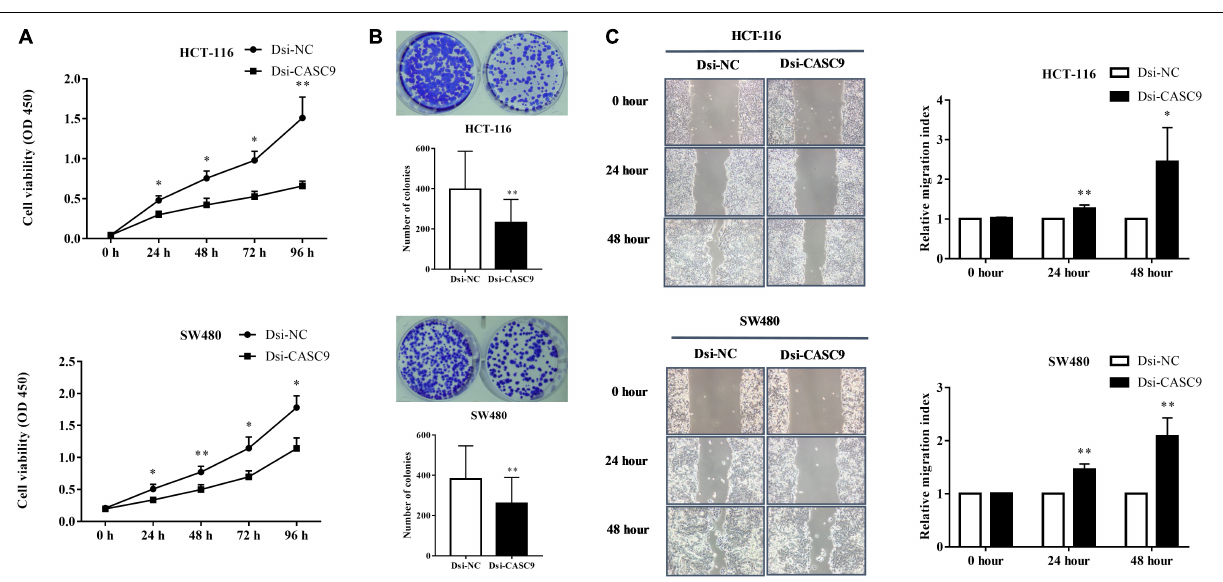
FIGURE 3 | Silencing of CASC9 reduced cell viability and colony formation and increased migration index of CRC cells. (A) The silencing of CASC9 led to significant decrease in HCT-116 and SW480 cell proliferation ( n = 4). (B) As determined by colony formation assay, the numbers of colonies in HCT-116 and SW480 were significantly reduced after CASC9 silencing ( n = 4). (C) After knockdown of CASC9, the migration index of HCT-116 and SW480 was significantly increased at both the 24- and 48-h time points ( n = 6), suggesting decrease in migration of cells to the gap. The data are shown as mean ± SEM compared to the negative control Dsi-NC (* P < 0.05, ** P <